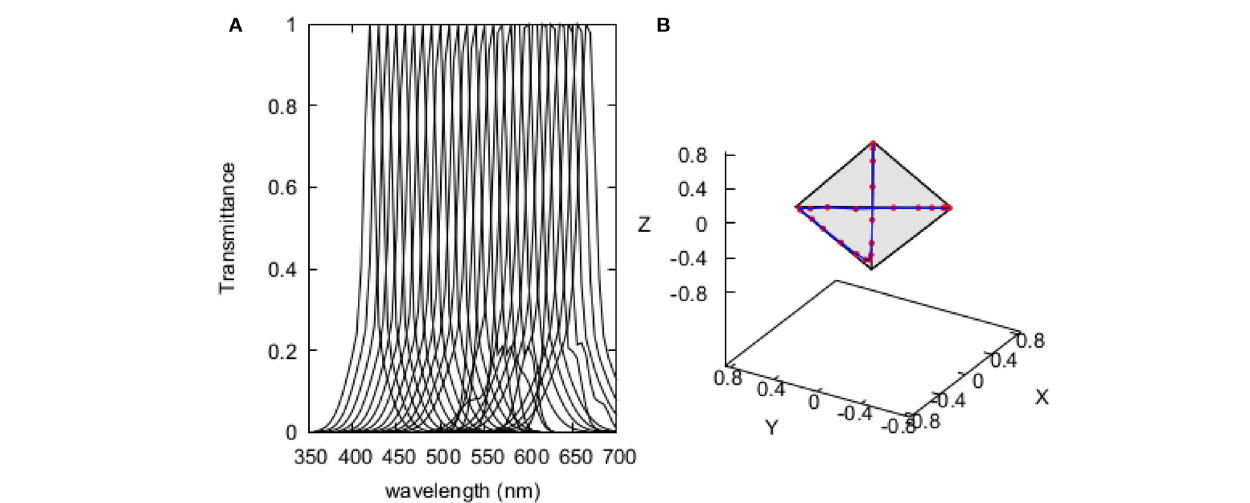
FIGURE 2 | Recovered spectral profiles of the 20 quasi-monochromatic stimuli used by Wright (1972) for determining the colour discrimination sensitivity index of the pigeon Columba livia (A) ; and, their representation in the tetrahedron space (B) . Spectral profiles were obtained by implementing Equation (2) using coefficients in Supplementary Table 1